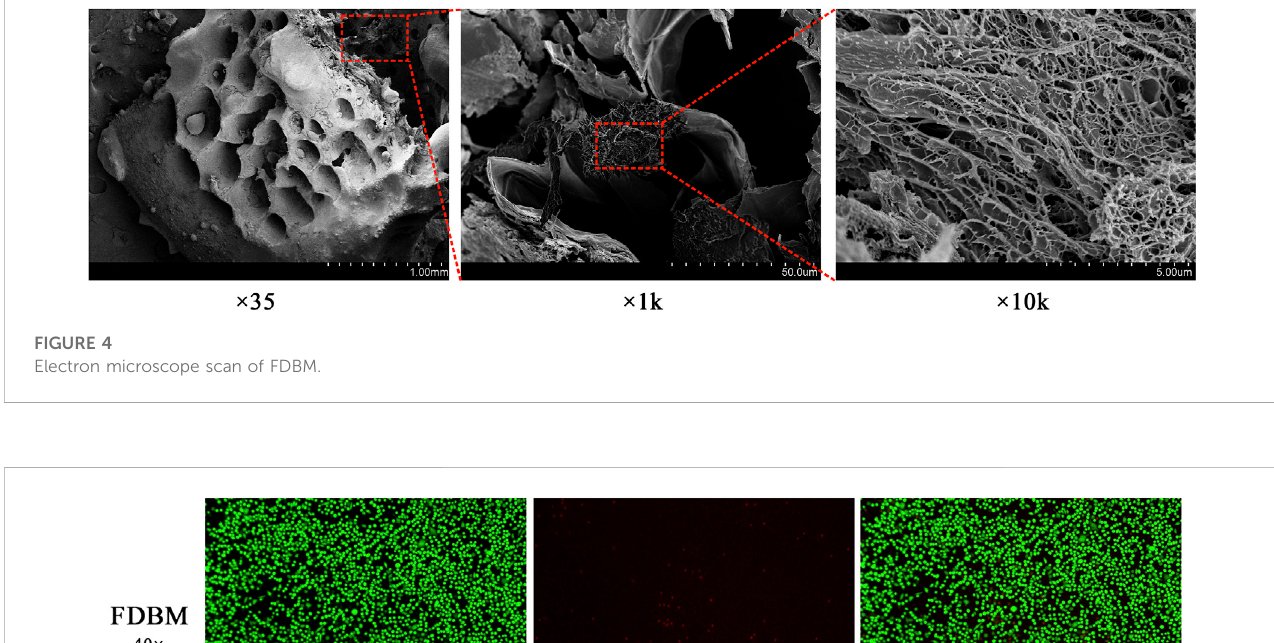
Frontiers in Bioengineering and